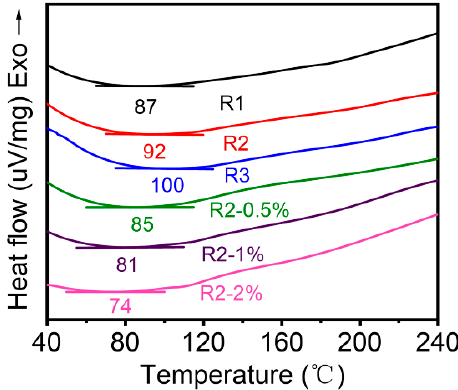
Figure 4. DSC curves of component